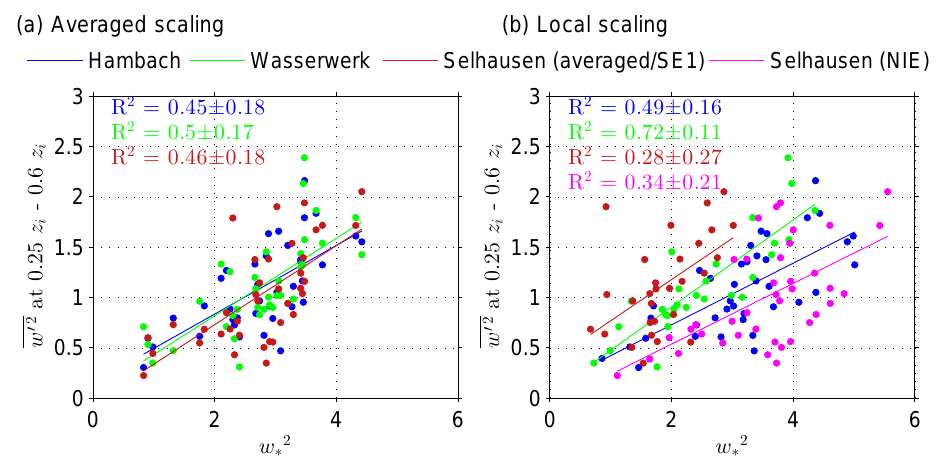
Figure 8. Correlations of vertical velocity variance averaged over 0.25 to 0 . 60 z i and w 2 ∗ , calculated using the weighted-averaged fluxes (a) and fluxes of nearby stations (b) for all time steps as in Fig. 7 but for 10:00–17:00UTC, with lines of best fit from linear regression, squared correlation coefficients R 2 and confidence interval at the 95%